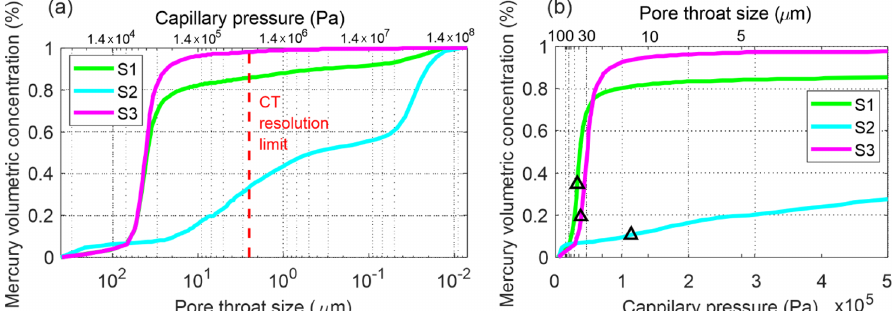
Figure 7. Cumulative pore throat sizes of the studied sandstones. (a) Capillary pressure on a logarithmic scale. The resolution limit of the micro-CT imaging indicates the fraction of the pore space that could be resolved. (b) Capillary pressure on a linear scale. The triangles indicate the characteristic length, l c .